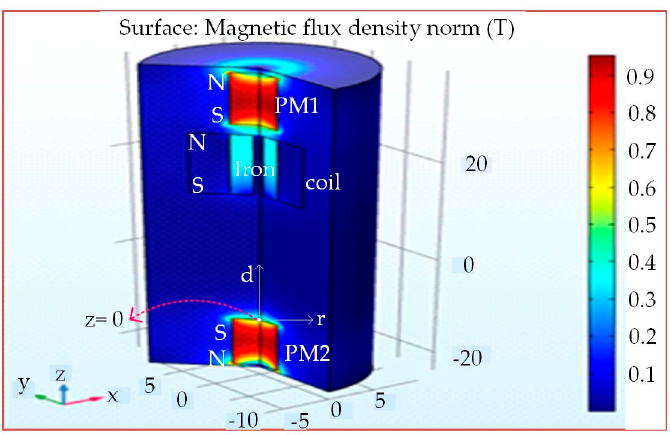
Figure 3. 3D Finite Element Model (FEM) of the CR.